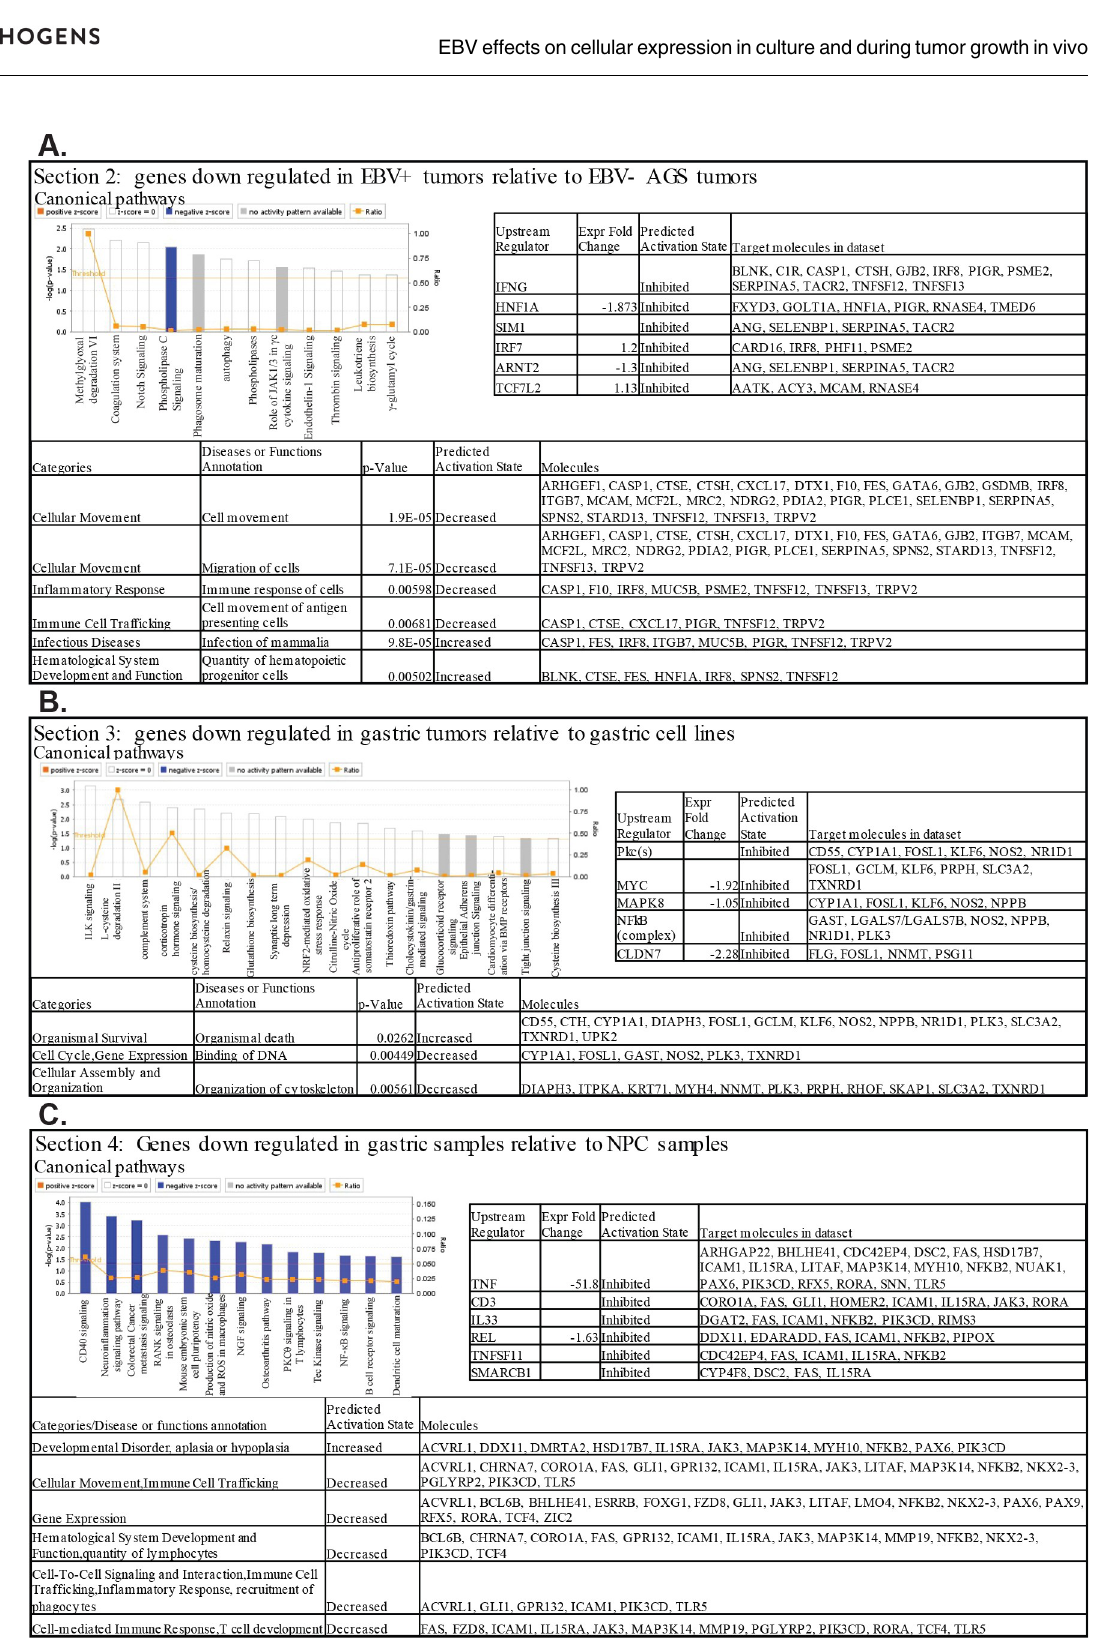
PLOS Pathogens| https://doi.org/10.1371/journal.ppat.1008071 October 4,